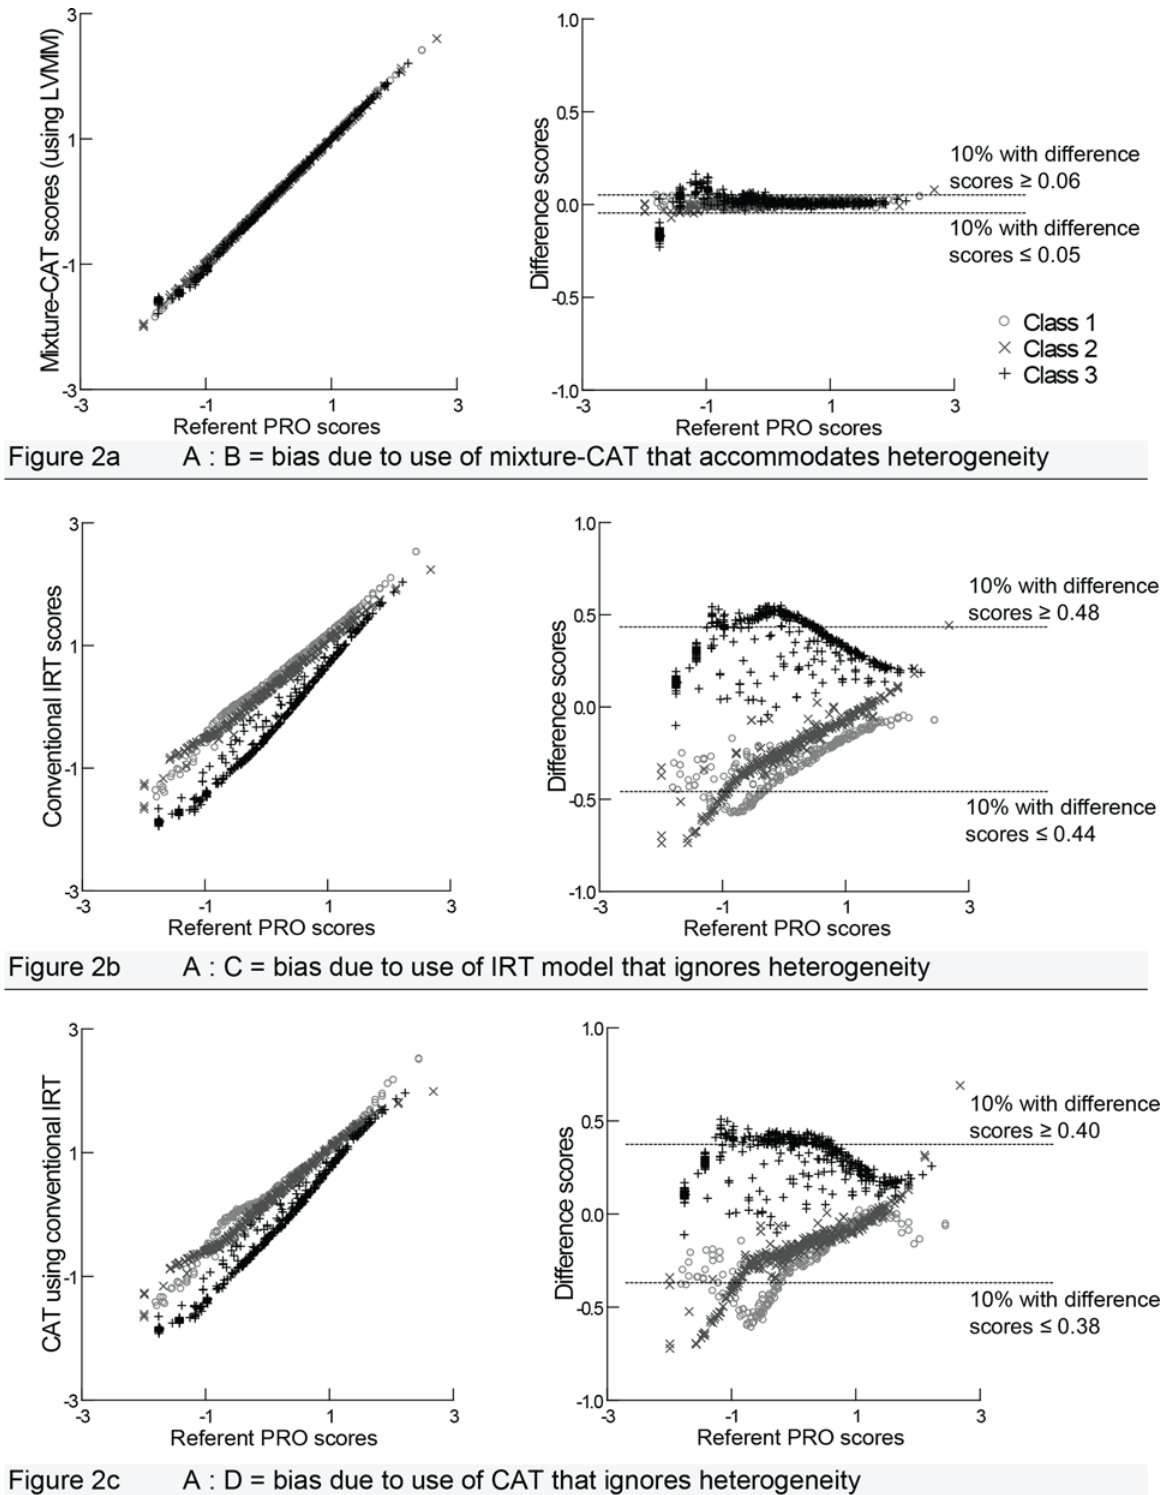
Fig 3. Impact of sample heterogeneity with respect to the predicted scores. Differences scores are the referent PRO scores minus the model predicted PRO scores based on 1,000 observations averaged across 100 simulated datasets. Although these are not class-specific scores (the referent scores are based on the LVMM), the latent classes are superimposed, as determined by the largest posterior probability, to visualize the bias within each class.